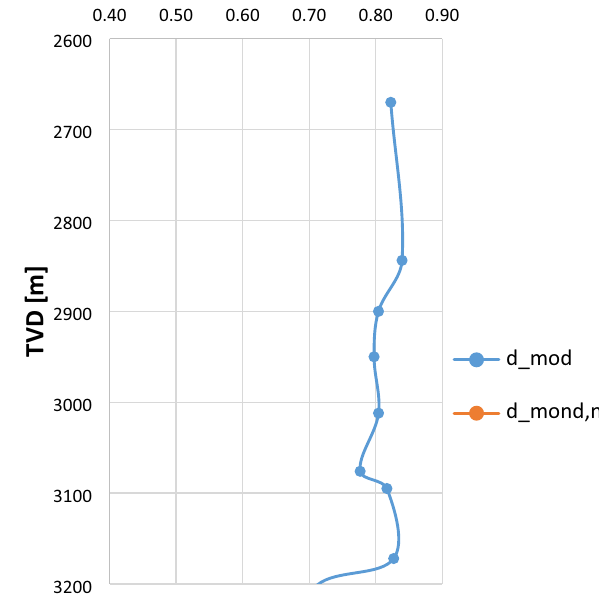
Fig. 10 Normal trend-line of the modified d -exponent (following fit- ting of Zamora’s model for Gachsaran formation) versus the modified d -exponent